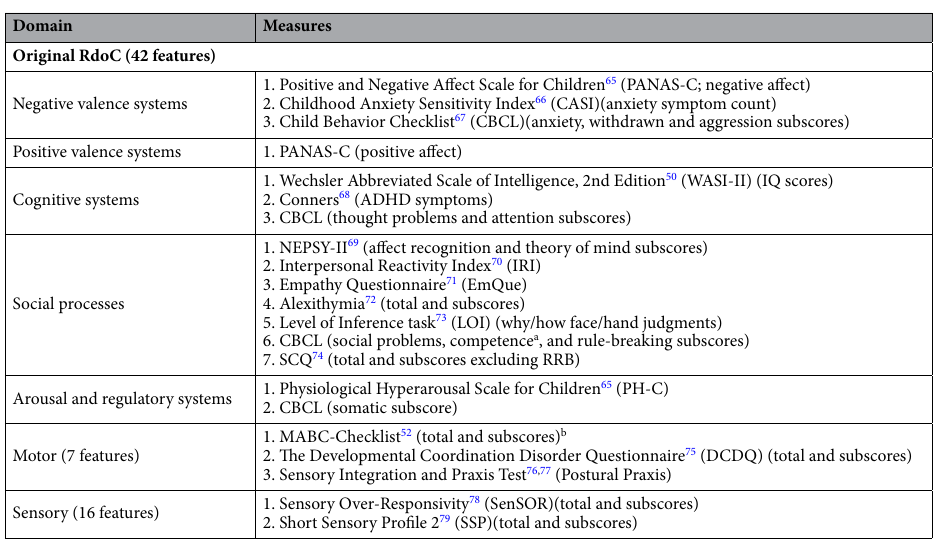
Table 7. Mapping of available measures to RDoC, motor, and sensory domains. a The CBCL competence score reflects participation and quality of performance in activities, social settings, and school. While it reflects aspects of cognitive performance, we include it in the social category as a measure of functionality in typical social environments. b The MABC and MABC checklist are normed for children up to 17 years of age. Our sample included one 17 year old, who was scored according to the norms used for a child aged 16 years and 11